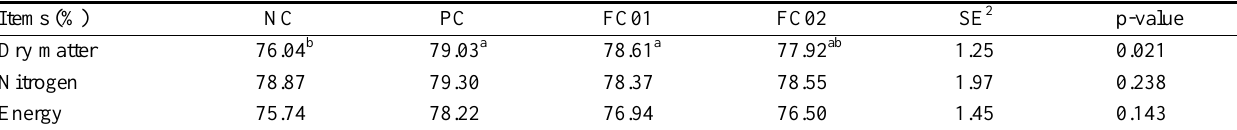
Table 3. Effect of fermented chlorella supplementation on nutrient digestibility in growing pigs 1 Items (%) NC Nitrogen